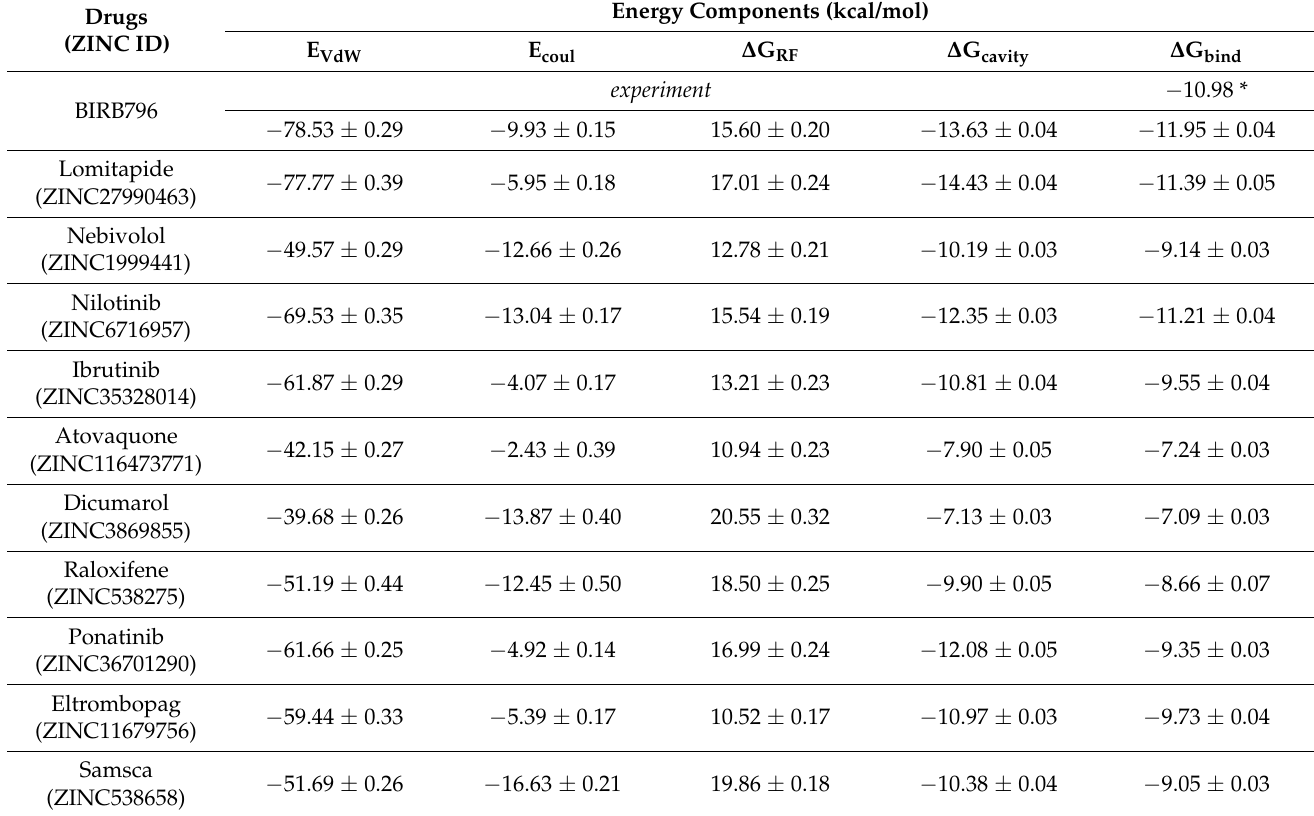
Table 1. ∆ G bind values (kcal/mol) of the candidate compounds as well as BIRB796 in complex with p38 α MAPK calculated by the SIE-based end-point method using α , γ , and constant coefficients of 0.10, 0.01, and − 2.89,